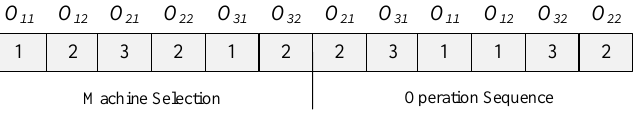
Figure 2. Denotation of Scheduling Scheme (SS).